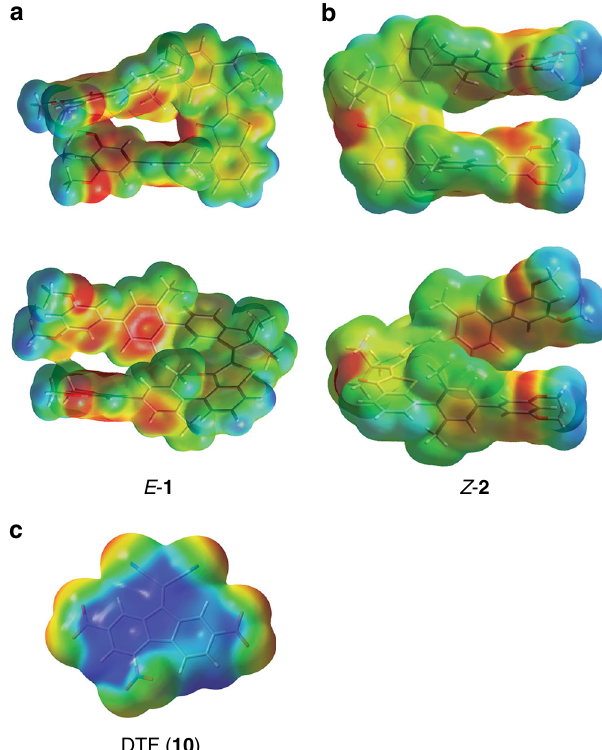
Fig. 4 Molecular structures and ESPs of tweezers 1 and 2 and DTF. Calculations were performed at the B3LYP/6-311 G(d,p) level of theory. Areas highlighted in red signify high electron density and areas highlighted in blue signify low electron density. a Two different views of E - 1 . b Two different views of Z - 2 . c DTF guest ( 10